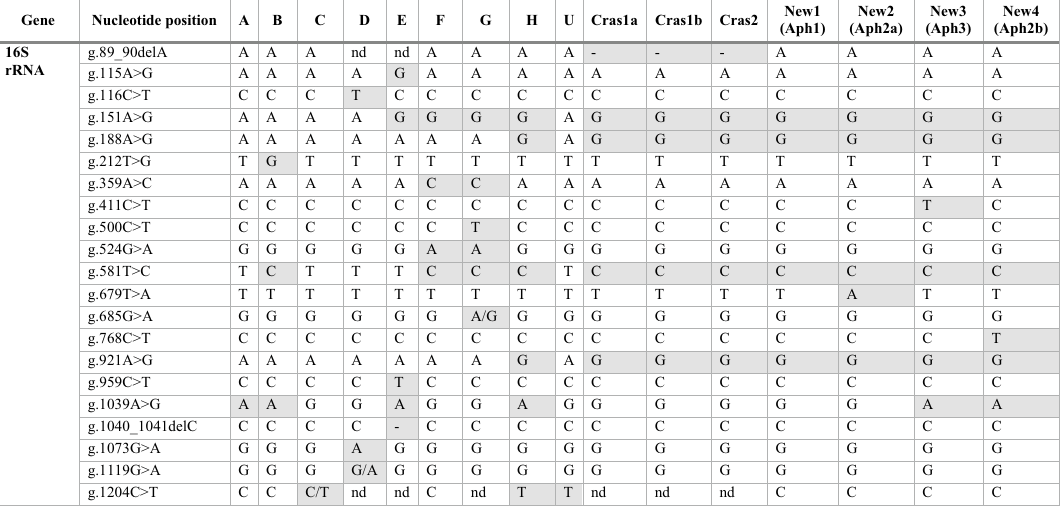
Table 1. Single nucleotide polymorphism comparison in the 16S rRNA gene between ‘ Ca. L. solanacearum’ haplotypes A, B, C, D, E, F, G, H, U, Cras1a, Cras1b, Cras2, and the four new sequence profiles described herein, New1 (ON569096; haplotype Aph1), New2 (ON569097; haplotype Aph2a), New 3(ON569098; haplotype Aph3), and New4 (ON569099; haplotype